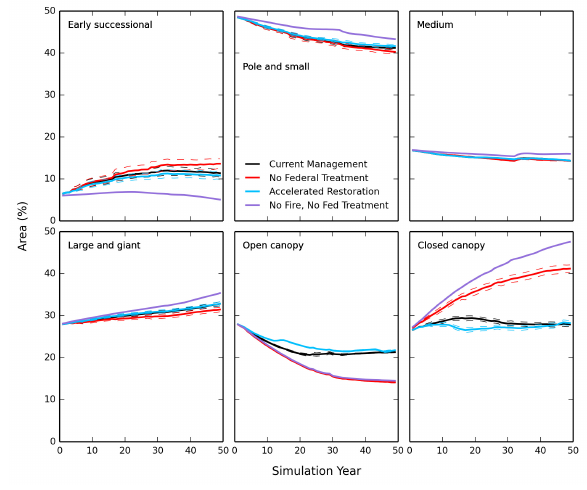
Fig. 9. Mean area of forest structural states over time for different management scenarios. Early successional = grasses, shrubs, and trees < 12 cm diameter at breast height (dbh); pole and small = trees 12–37 cm dbh; medium = trees 37–50 cm dbh; large and giant = trees > 50 cm dbh; open canopy = trees > 25 cm dbh and cover < 40%; closed canopy = trees > 12 cm dbh and canopy > 60% cover. Broken lines indicate corresponding 95% confidence intervals for 15